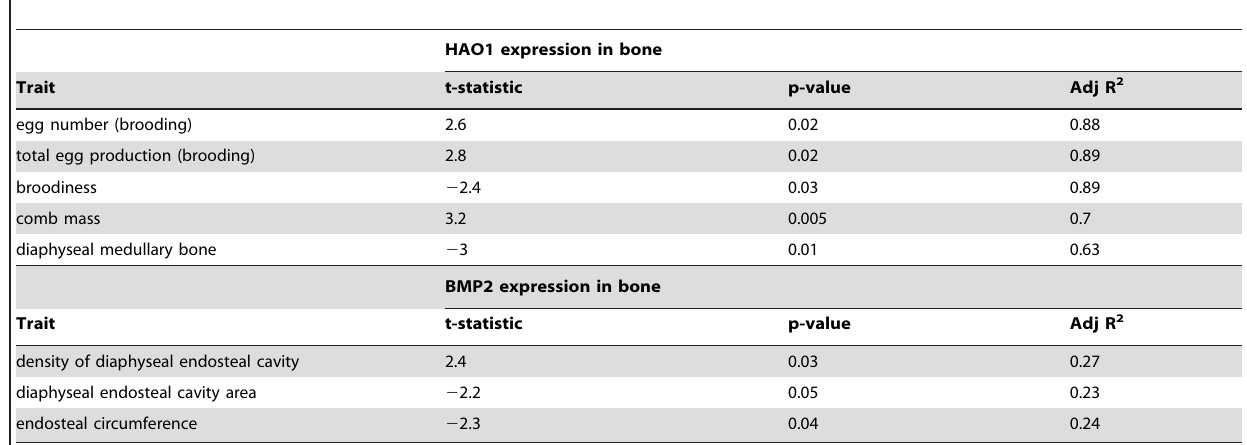
Table 3. Additional fecundity and bone morphometric traits correlated with HAO1 and BMP2 expression in bone samples.